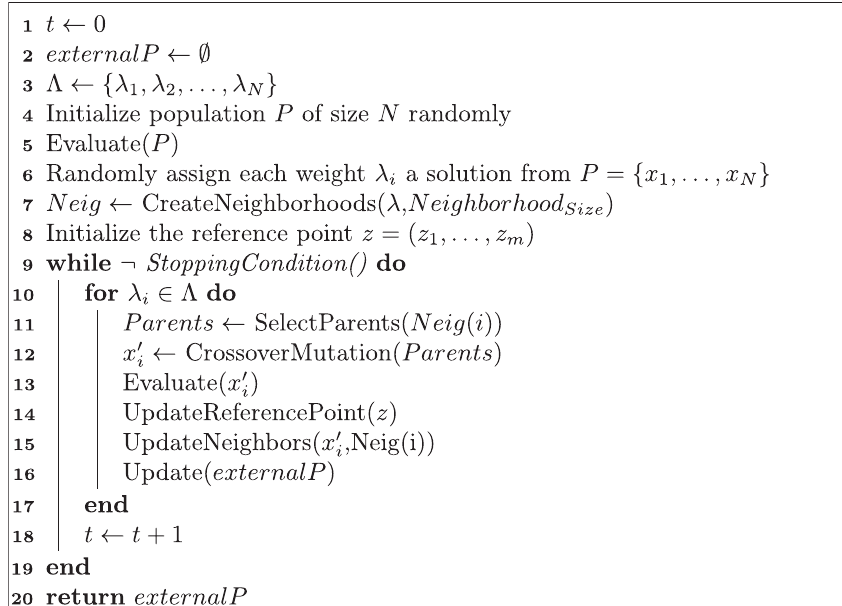
Figure 11: Pseudocode of a